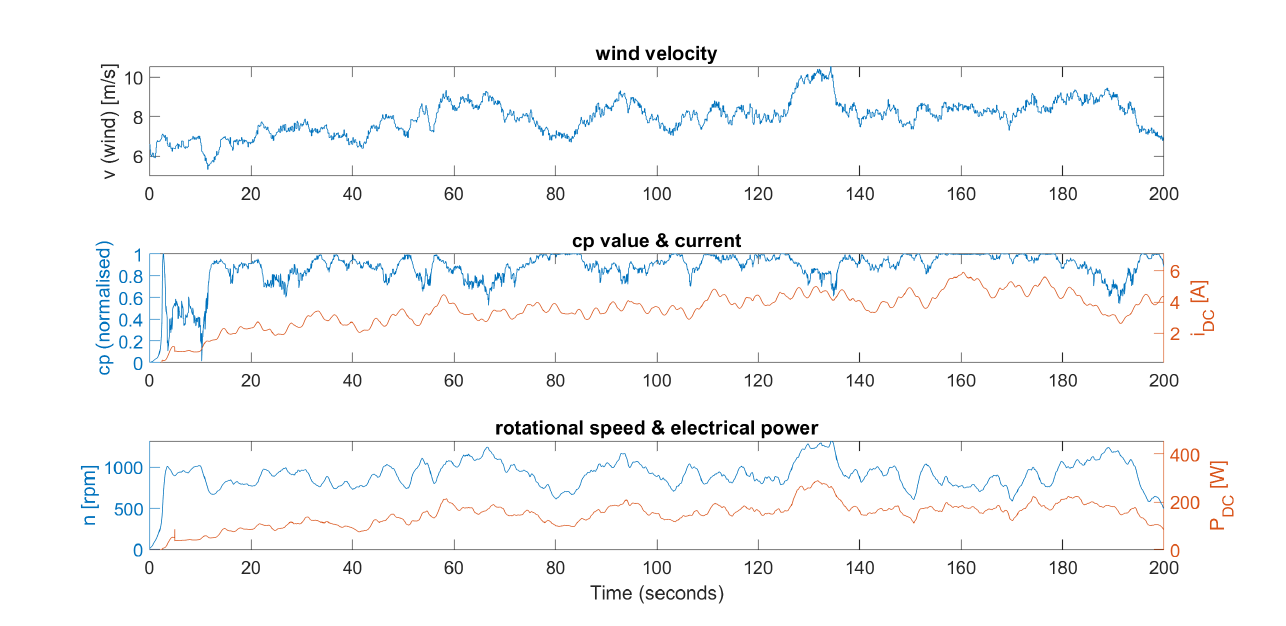
Figure 7. Simulation results with real wind data from collected in Kaiser-Wilhelm-Koog on the shore of the North Sea at a height of 10